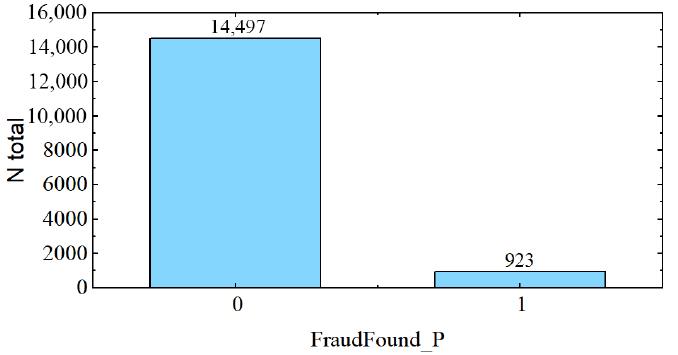
Figure 4. Class distribution of fraud in the selected dataset. The x axis represents the two classes of No Fraud Found (FraudFound_P = 0) and Fraud Found (FraudFound_P = 1). The FraudFound class represents 6.36% of the total